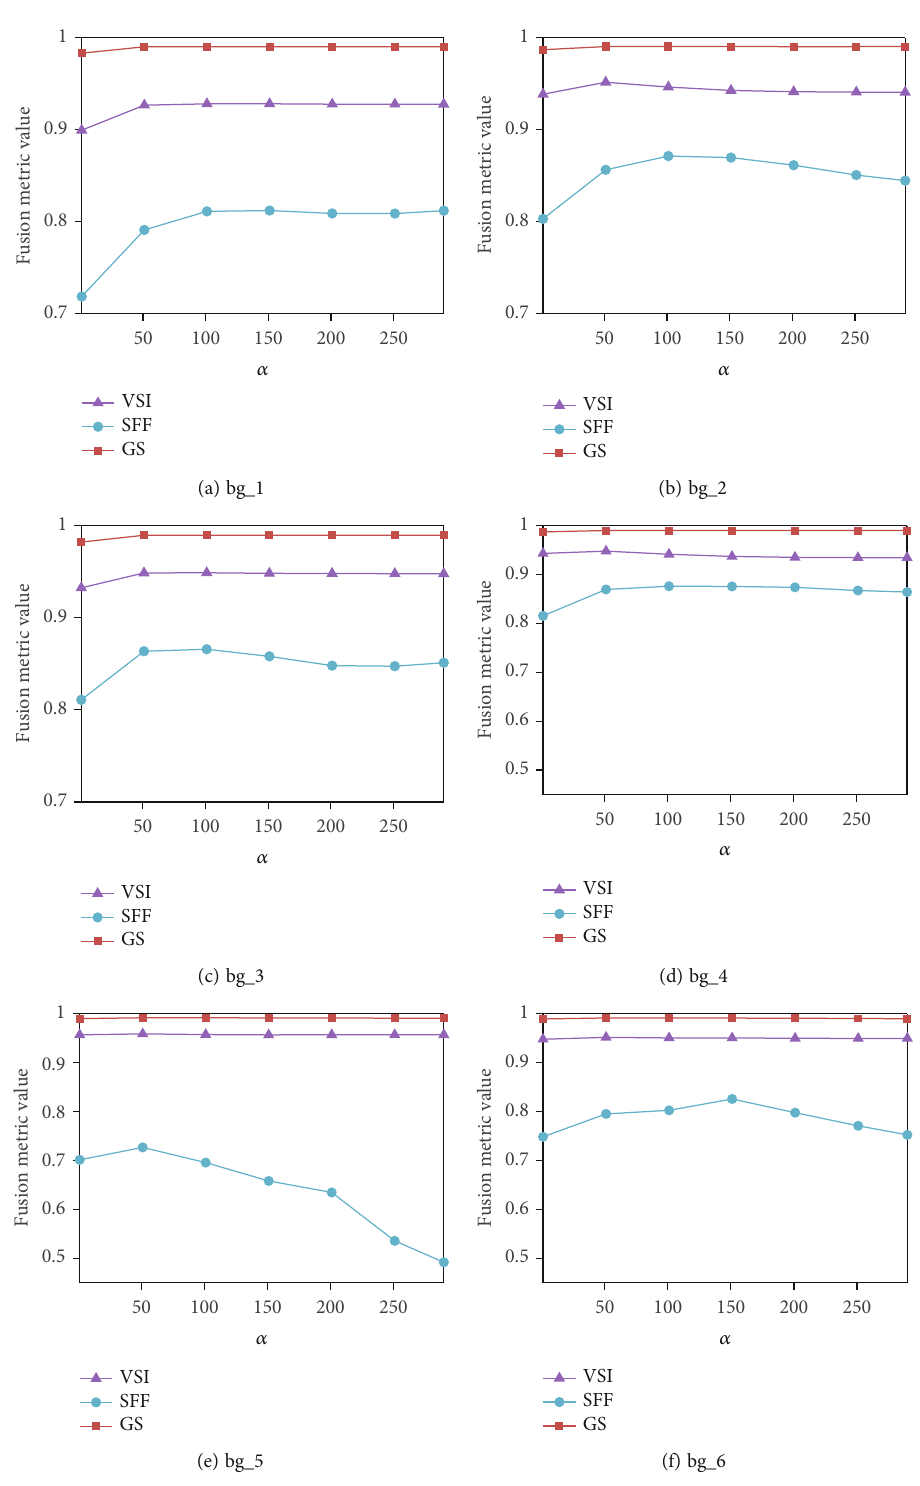
Figure 5: Performance of the proposed method with di ff erent settings of parameter α for di ff erent